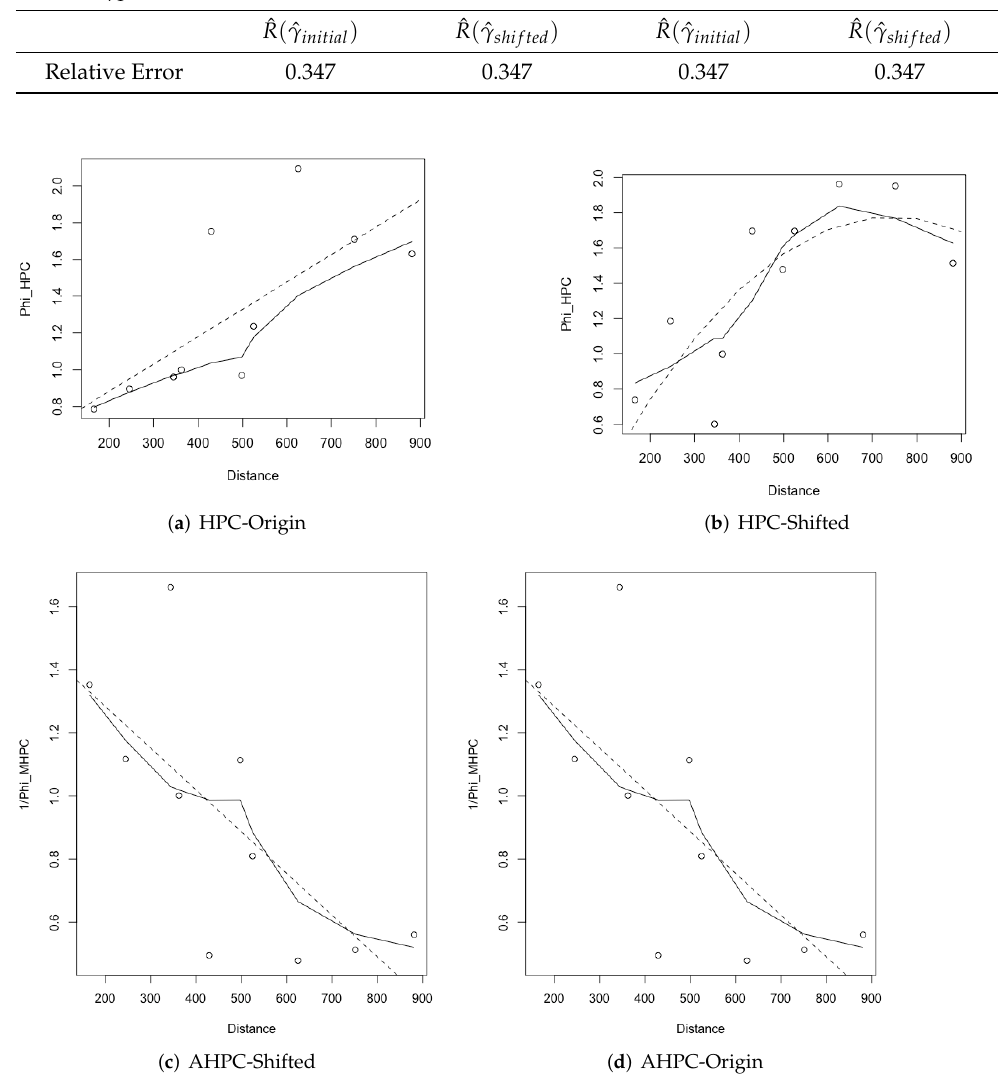
Figure 8. Solid and dotted lines are non-parametric smooth and fitted model of covariance compo- nents Φ (circles in each plots) under HPC and AHPC methods separately with respect to distances between five stations, under initial and shifted